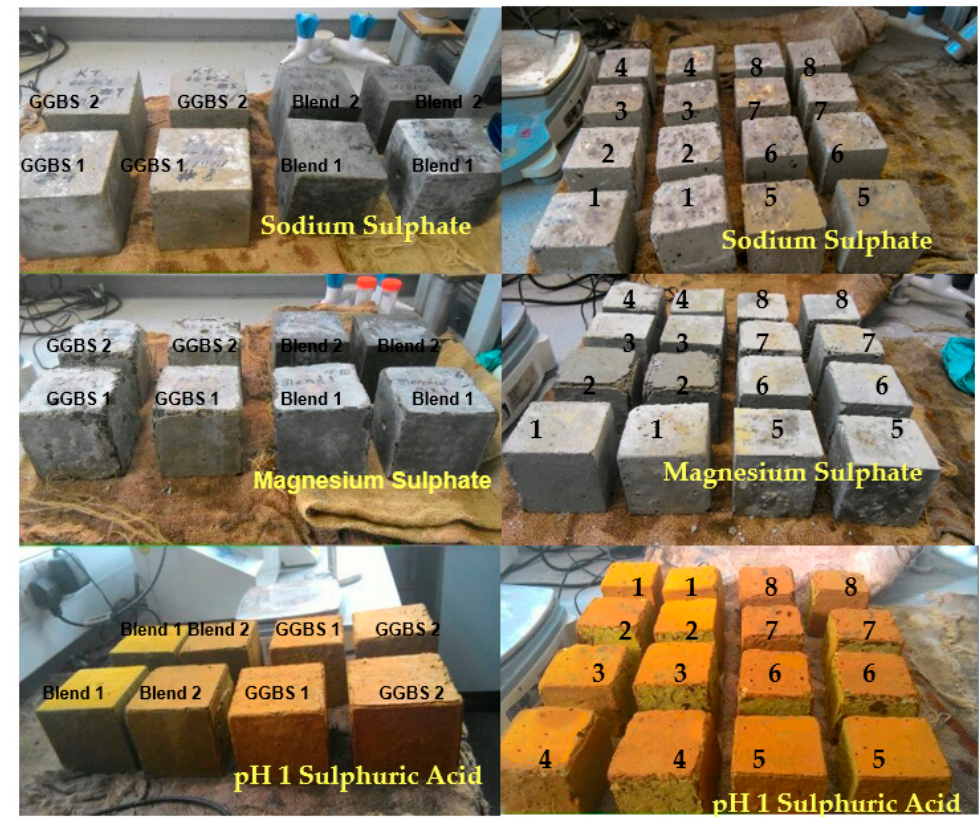
Figure 4. The visual appearance of the concrete specimens after 14 months of exposure to various solutions. Group 1 specimens are shown on the left-hand side and Group 2 on the right. The corners and edges were damaged for specimens exposed to MgSO 4 and sulphuric acid. Note the brown/orange colouration of specimens exposed to sulphuric acid.